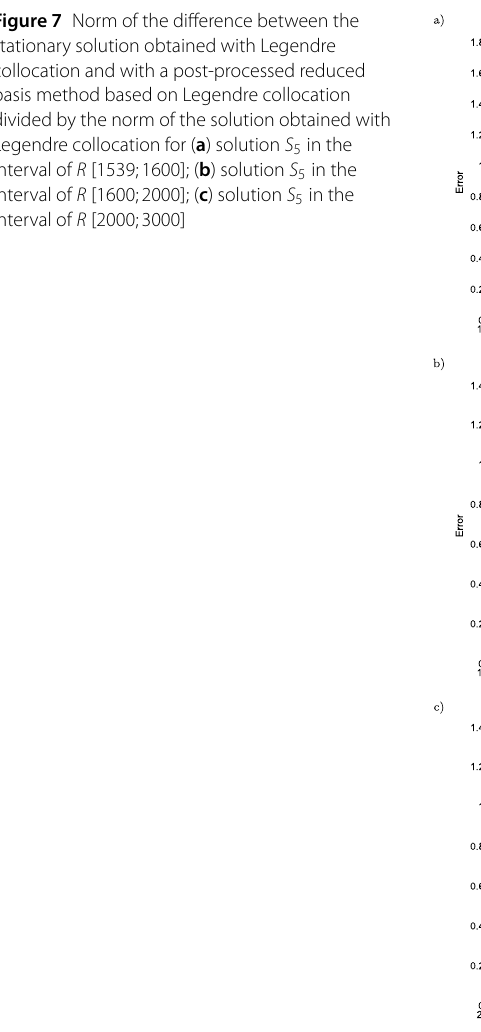
Figure 7 Norm of the difference between the stationary solution obtained with Legendre collocation and with a post-processed reduced basis method based on Legendre collocation divided by the norm of the solution obtained with Legendre collocation for ( a ) solution S 5 in the interval of R [1539;1600]; ( b ) solution S 5 in the interval of R [1600;2000]; ( c ) solution S 5 in the interval of R